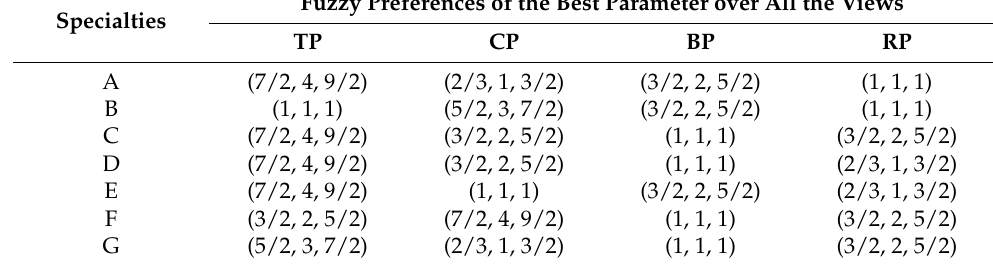
Table 7. The FBO vectors.